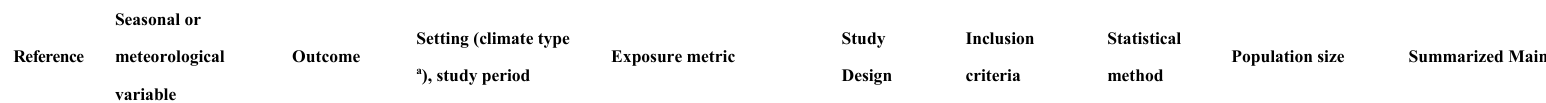
Table 1. Associations between meteorology and the hypertensive disorders of